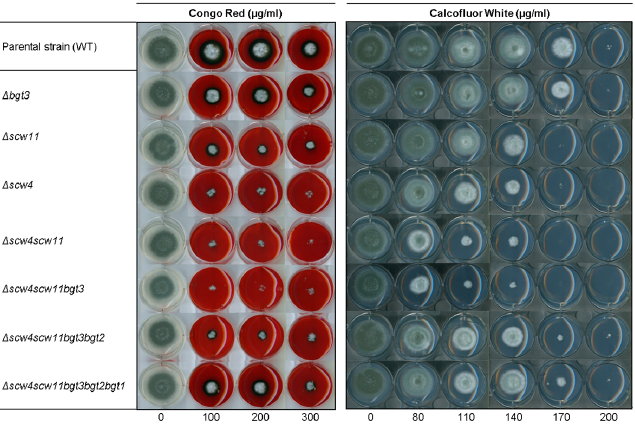
Figure 6. Sensitivity of the family GH17 deletion mutants to cell wall perturbing agents congo red (CR) and calcofluor white (CFW) after 72 h growth at 37 °C on MM agar media (1.5 × 10 6 conidia were spotted). Experiments were performed in triplicate.